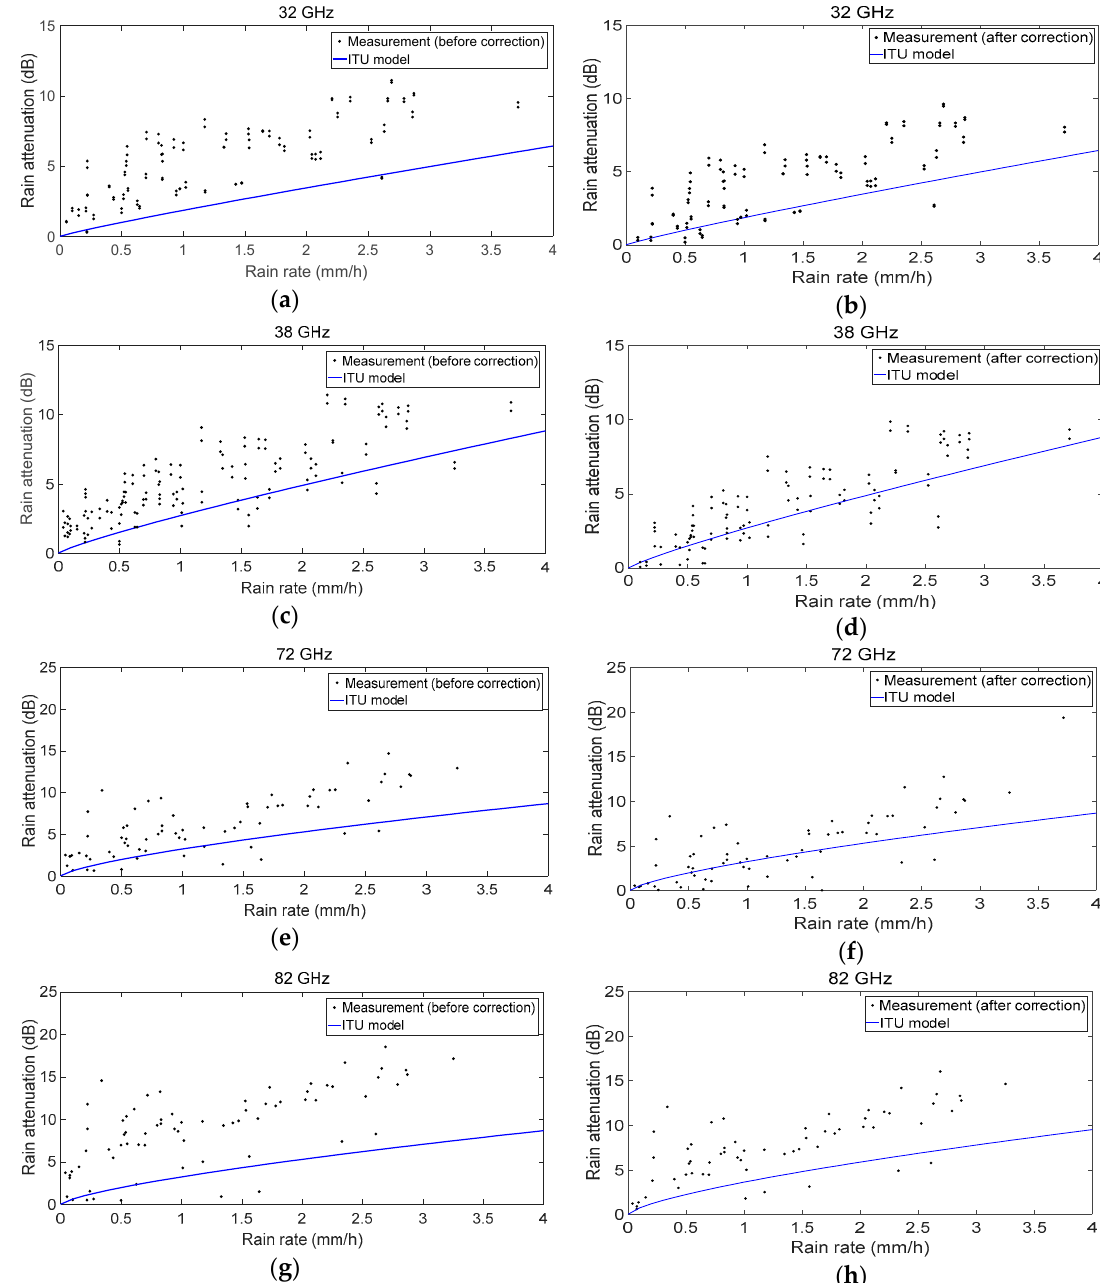
Figure 7. Rain attenuation statistics from the measurement before correction and after correction in comparison with the calculated rain attenuation, using the ITU model from Equation (9) for different frequencies: ( a )-( b ) 32 GHz; ( c )-( d ) 38 GHz; ( e )-( f ) 72 GHz; ( g )-( h ) 82 GHz.